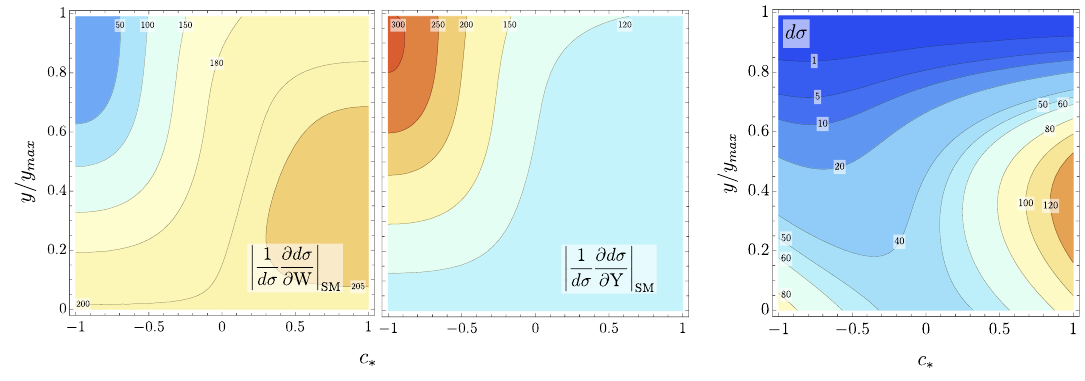
Figure 1 . Left panel: absolute value of the logarithmic derivative of the tree-level differential cross- section with respect to the W and Y parameters in the ( c ∗ , y ) plane. Right panel: level contours of the tree-level SM differential cross-section (in arbitrary units). Both plots are obtained at fixed m ‘‘ = 1